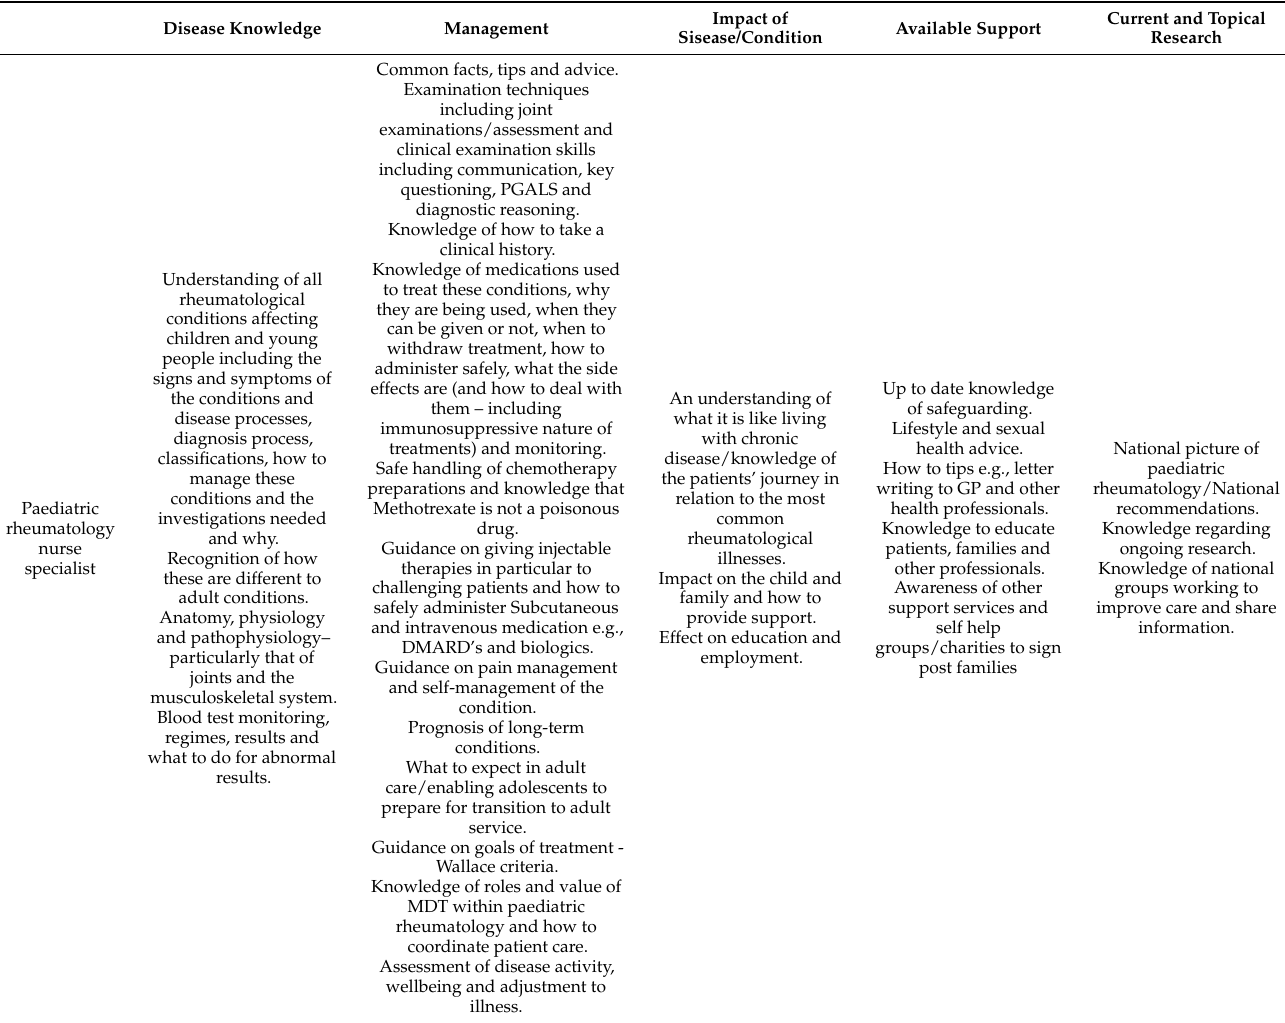
Table 1. Breakdown of knowledge required by nursing